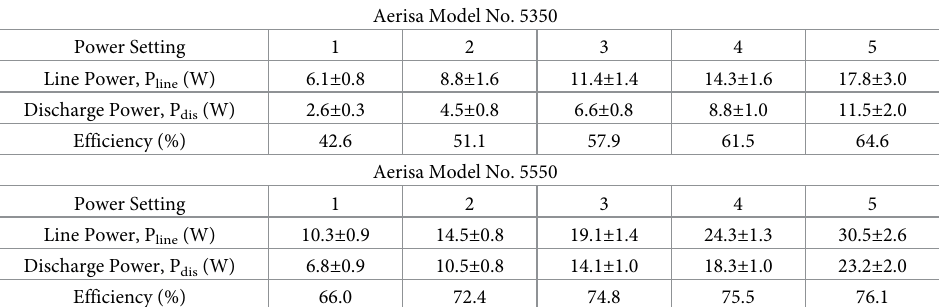
Table 2. Measured line powers, discharge powers, and their corresponding electrical efficiency of Aerisa DBD